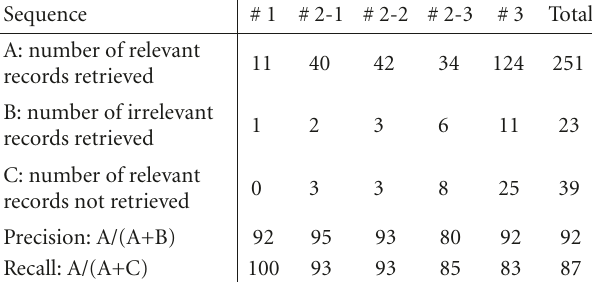
#2-3: (a) #2-1, (cid:0)